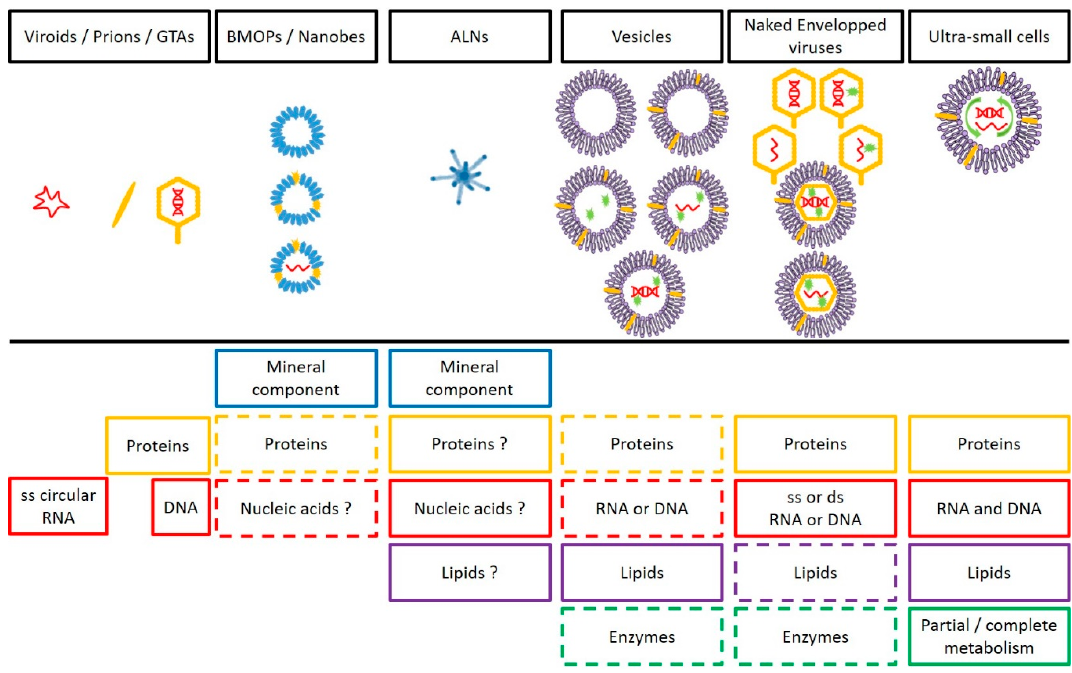
Figure 6. Schematic overview of the main components and of organizational complexity (increase in complexity from left to right) of the femtoplankton entities mentioned in this review. The question mark (?) represent uncertainty about the presence/absence of this compound in the target entity. The dotted line (--) means “Optional”. GTAs = gene transfer agents, BMOPs = Biomimetic mineral–organic particles, ALNs = aster-like nanoparticles. Note that the tail (mainly an attribute of bacteriophages) is not present in all naked viruses.